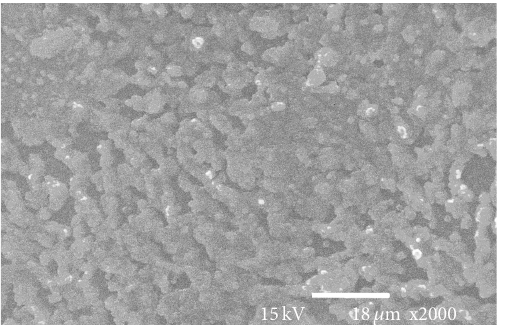
Figure 3: SEM pictures of hybrid membrane of carboxymethyl chi- tosan and silicon dioxide.